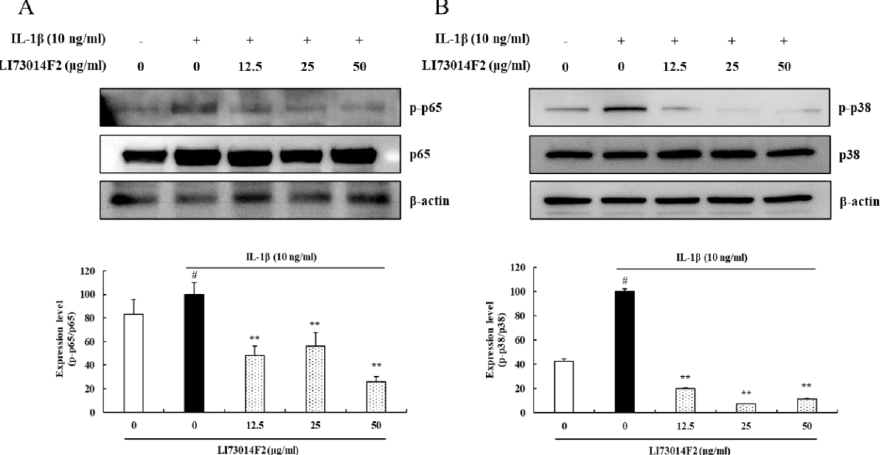
Figure 5. Effects of LI73014F2 on the NF- κ B and Mitogen-activated protein kinase (MAPK) signaling pathway in IL-1 β -stimulated HCH cells. HCH cells were pretreated with LI73014F2 (12.5, 25 and 50 µ g / mL) for 24 h, followed by incubation with IL-1 β (10 ng / mL) for 30 min. ( A ) The protein expression levels of NF- κ B p65 (65 kDa) and phospho-NF- κ B p65 (65 kDa) were examined by western blot analysis. ( B ) The protein expression levels of p38 MAPK (40 kDa) and phospho-p38 MAPK (43 kDa) were determined by western blot analysis. western blot bands were analyzed using Image J software. β -actin was used as a control for normalization. # P < 0.05, compared with the vehicle control group. * P < 0.05 and ** P < 0.01, compared with the IL-1 β -treated control group.